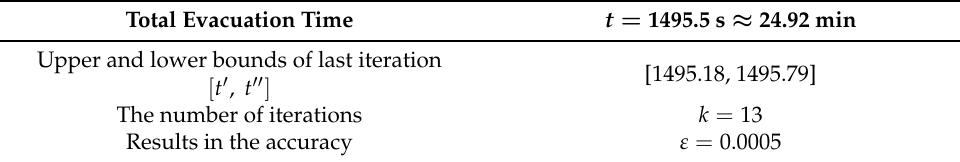
Table 5. Algorithm 1 calculation effects and target values.